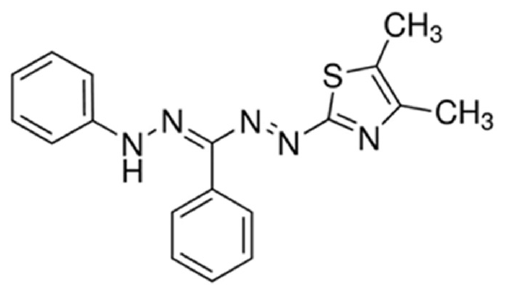
Figure 1. The chemical structure of formazan.